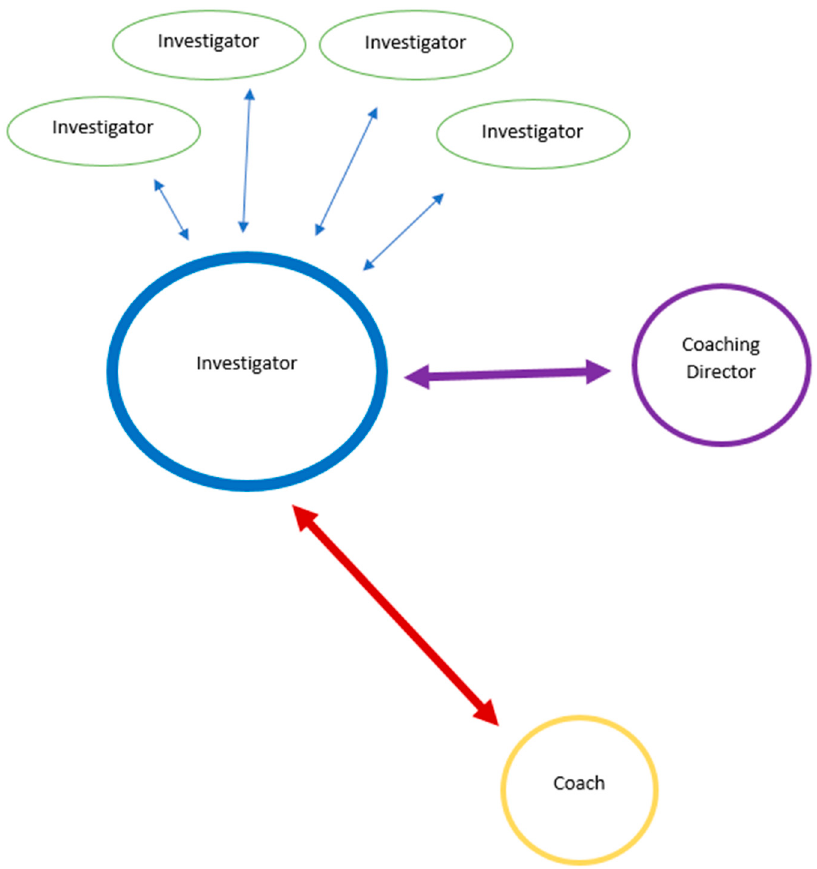
Figure A1. Diagram of social network in coaching group in collaboratory.